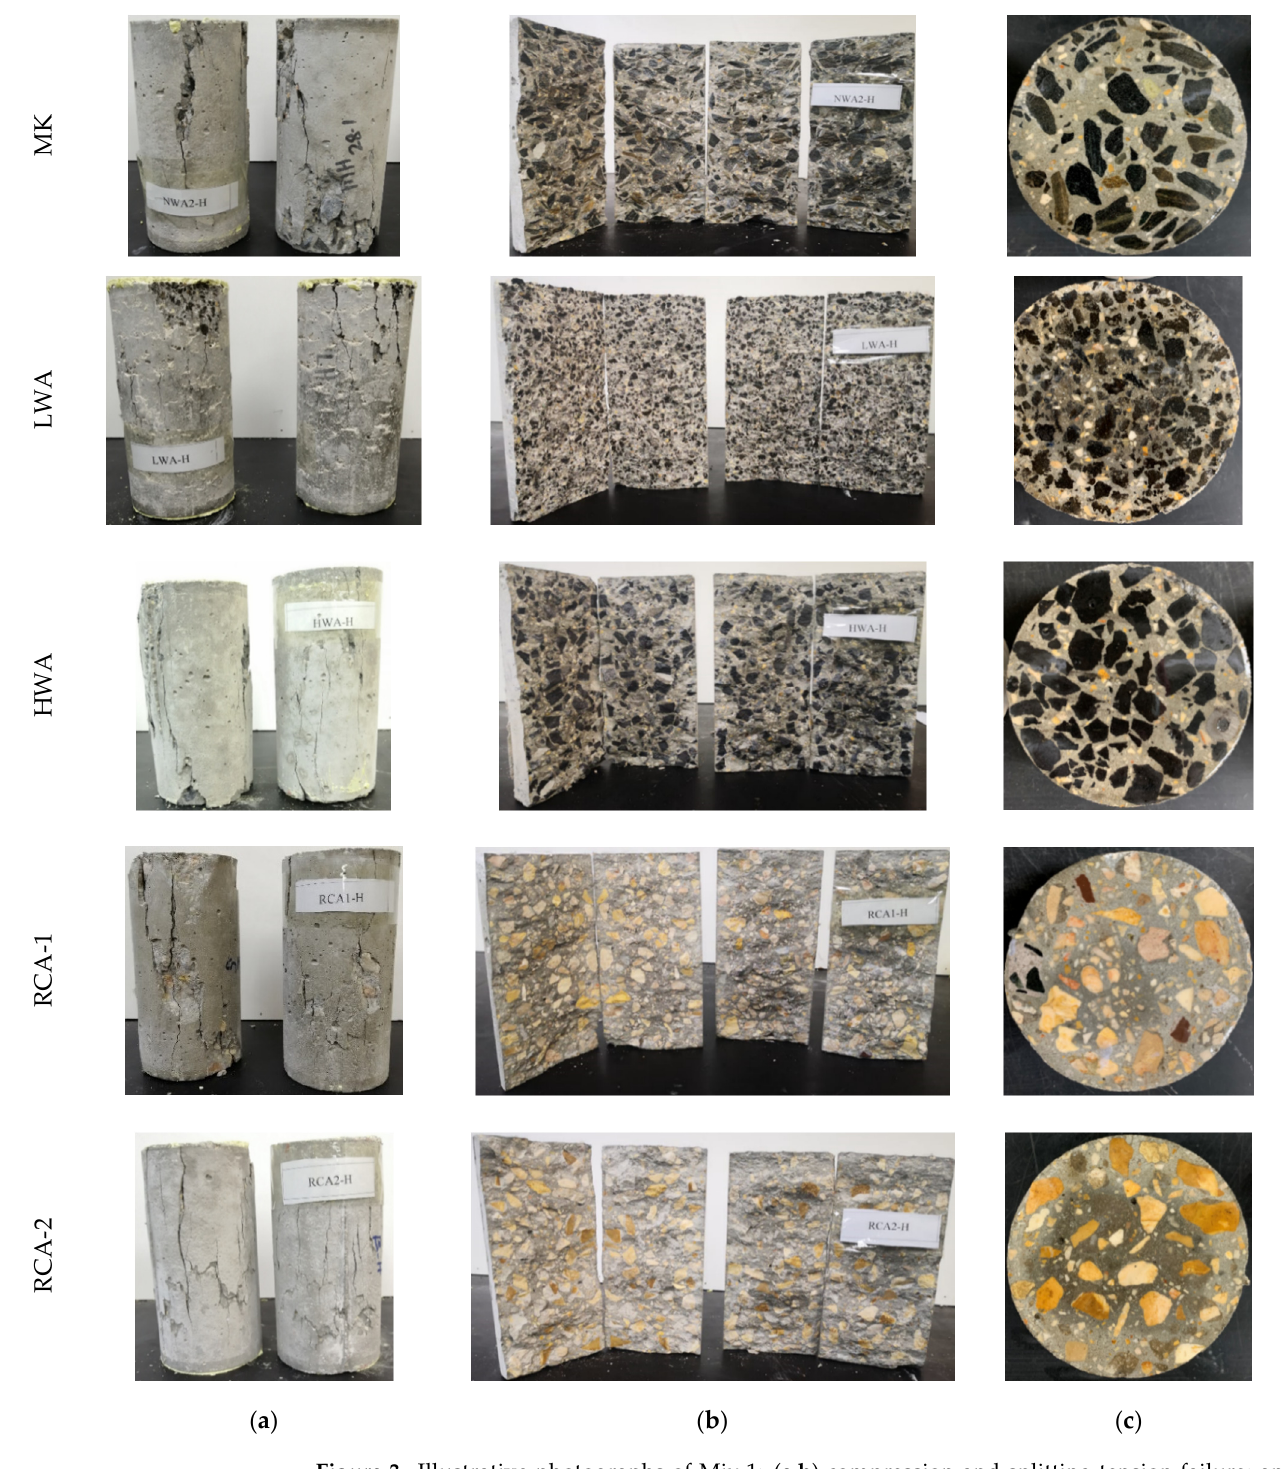
Figure 3. Illustrative photographs of Mix 1: ( a , b ) compression and splitting tension failure; and ( c ) cross section.